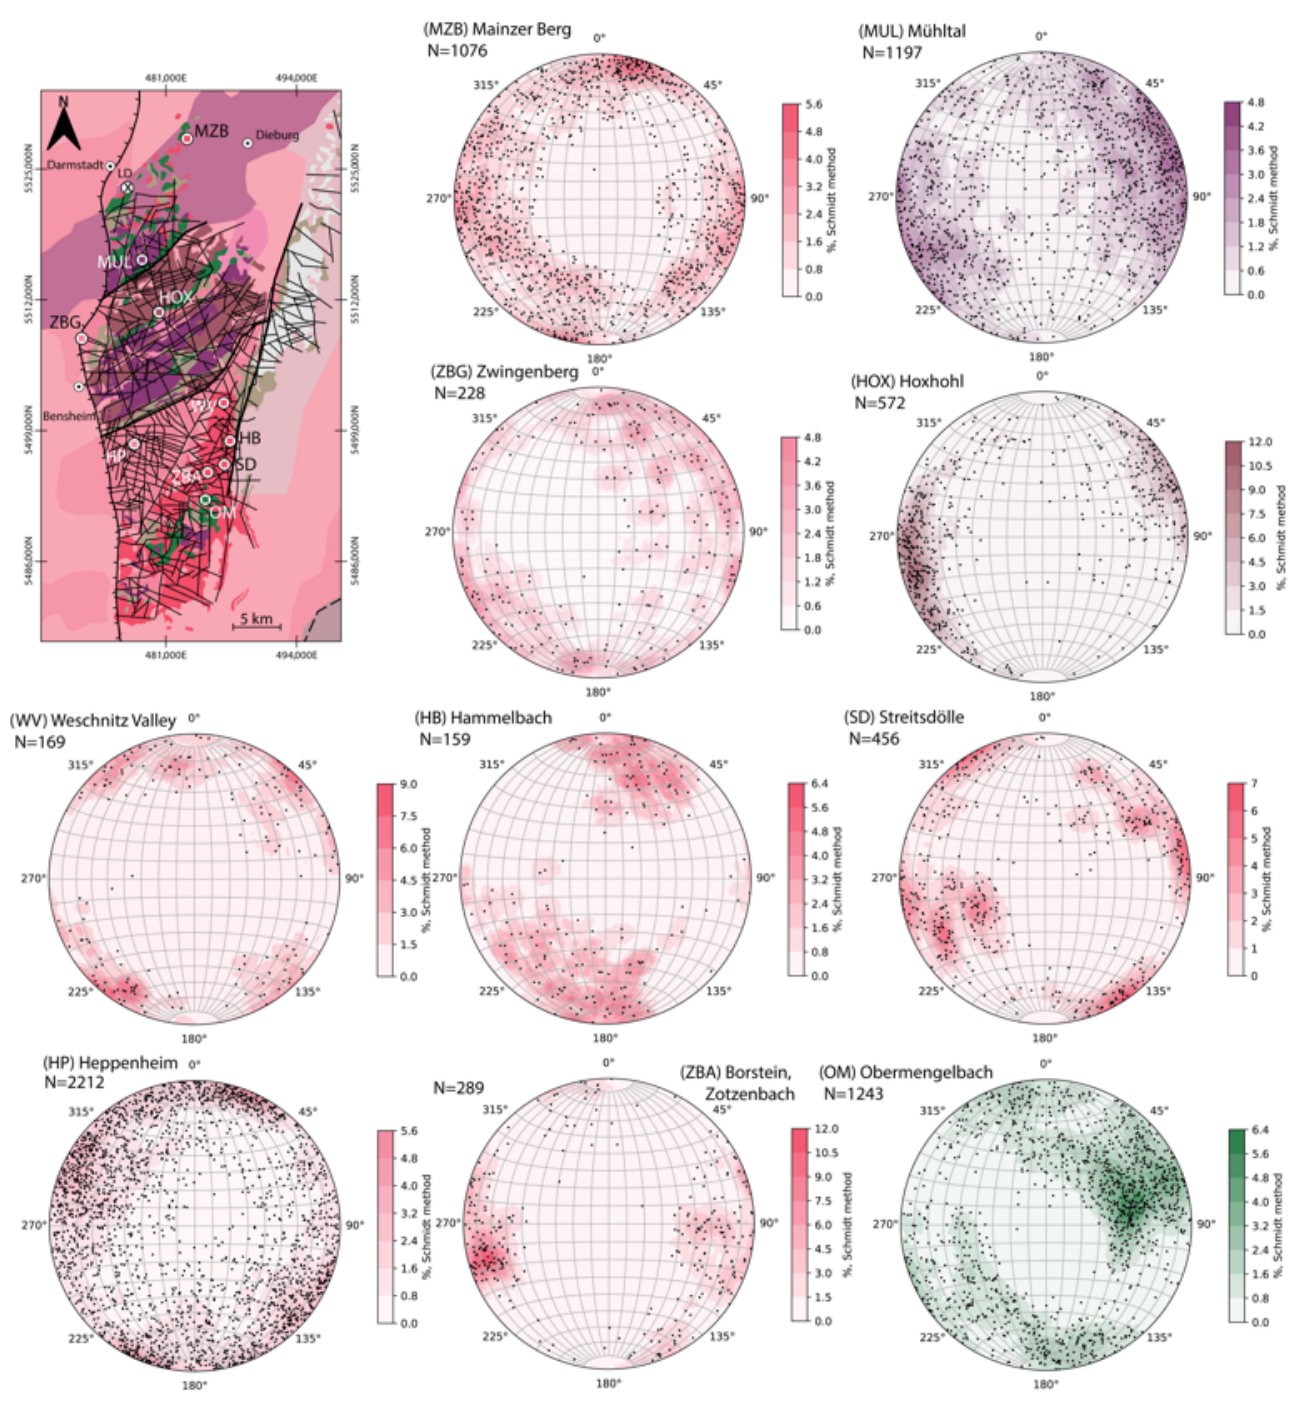
Figure 4. Orientation of the fracture network from outcrops with the mini-map, with outcrop location and Schmidt canvas with lower hemisphere projection stereograms. The applied colour code is related to the particular host lithology (see Figure 1).